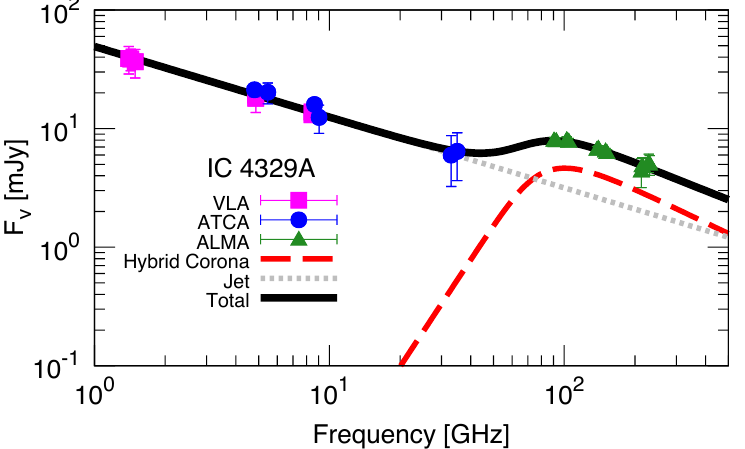
Figure 5. The cm–mm spectrum of IC 4329A after subtracting extended emission due to galactic star formation activity. The square, circle, and triangle points show the VLA, ATCA, and ALMA data, respectively. The error bars correspond to 1- σ uncertainties. The dashed and dotted lines show the fitted hybrid corona and jet components, respectively. The solid line shows the sum of these two components. Taken from Inoue and Doi [37].